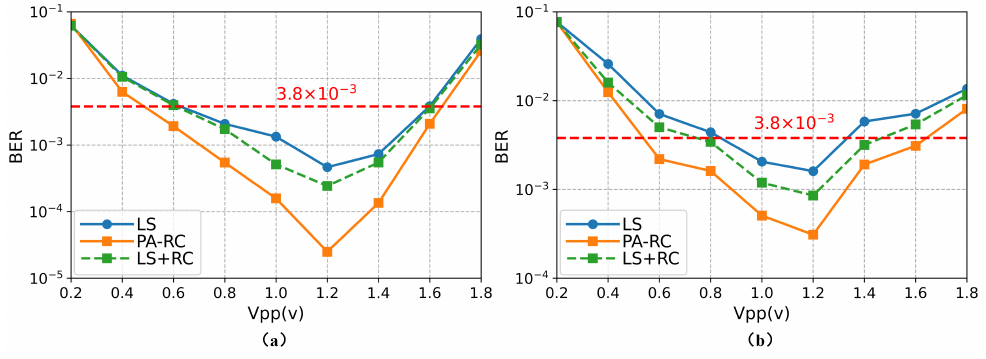
Figure 6. BER vs. signal Vpp. ( a ) The data is 120 Mbps; ( b ) the data is 240